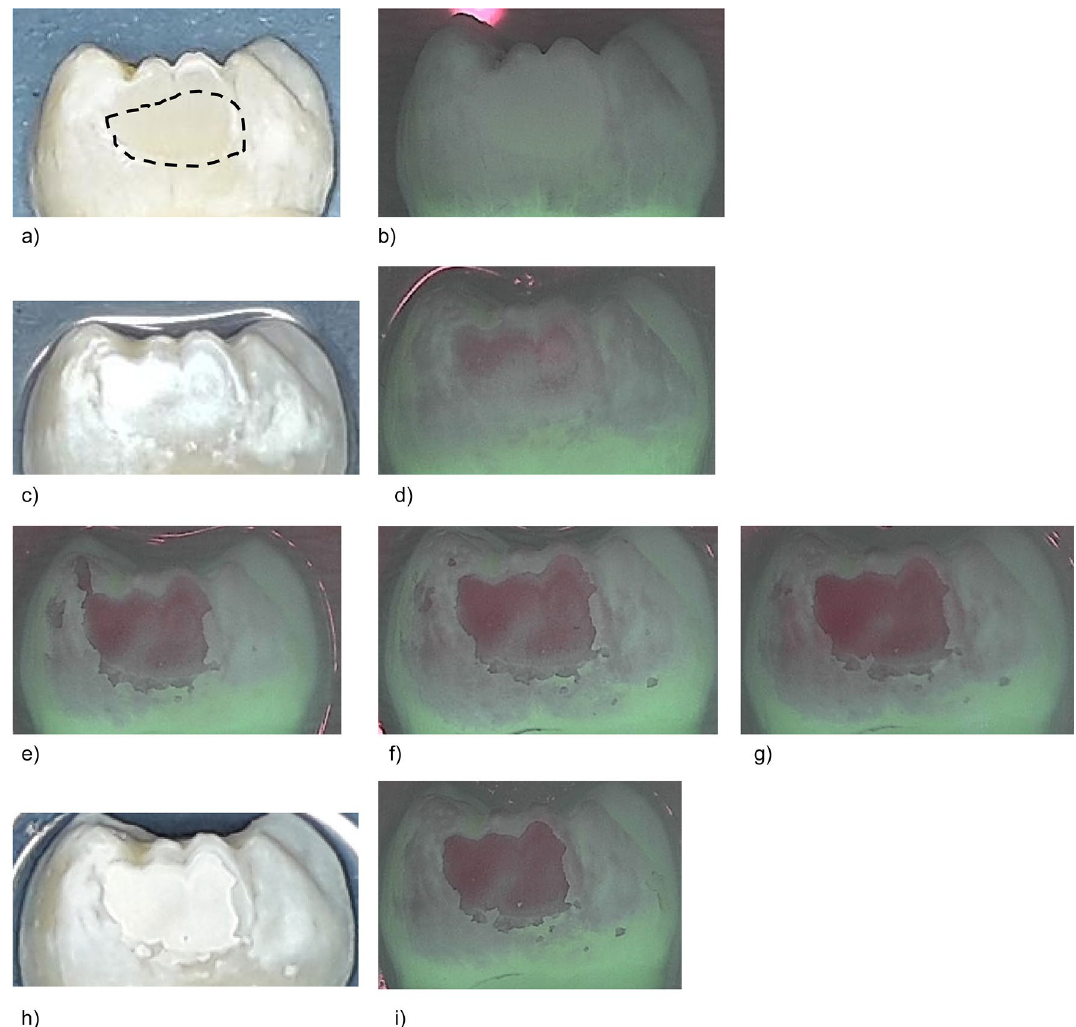
Figure 2. Standard image and QLF image of a representative sample in group II (Bifluorid 12, sample #12) at different investigation times. The dashed line indicates the ground surface where the QLF measurements were performed. ( a ) Prior to demineralisation. ( b ) Corresponding QLF-image: ΔF = 0.0%; ΔFmax = 0.0%. ( c ) After demineralisation (T-demin). ( d ) Corresponding QLF-image (T-demin): ΔF = − 11.3%; ΔFmax = − 20.9%. ( e ) QLF image T07: ΔF = − 17.7%; ΔFmax = − 36.7%. ( f ) QLF image T14: ΔF = − 17.1%; ΔFmax = − 36.2%. ( g ) QLF image T21: ΔF = − 13.3%; ΔFmax = − 30.1%. ( h ) 28 days after demineralisation (T28). (2 i ) Corresponding QLF- image (T28): ΔF = − 15.7%; ΔFmax = −